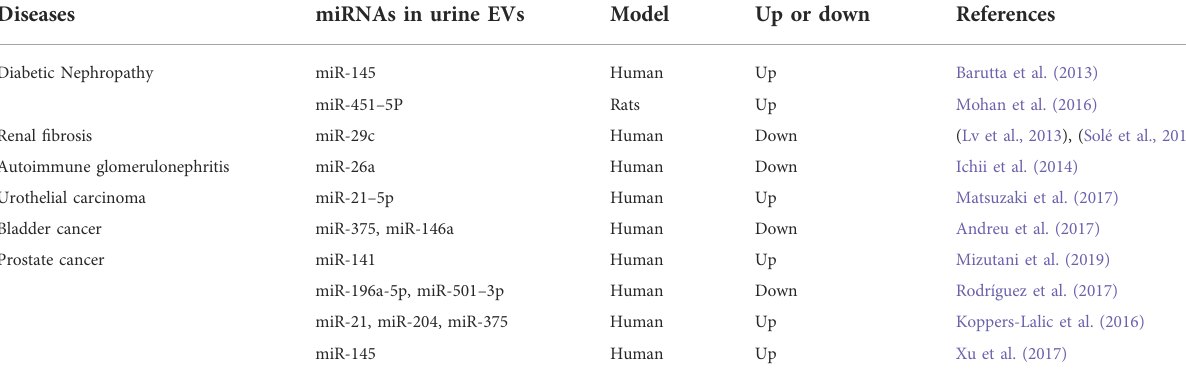
TABLE 1 MiRNAs associated with kidney diseases in urine EVs. Diseases